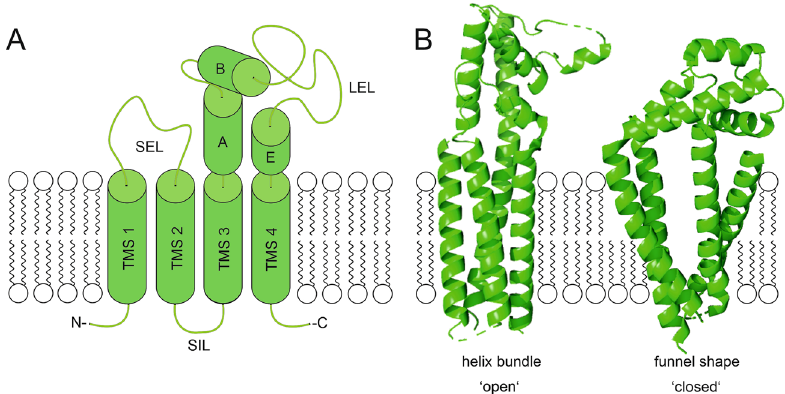
Figure 1. Tetraspanin topology and open-/closed-conformation. Tetraspanin embedded into a membrane bilayer; top and bottom correspond to the extracellular and intracellular side, respectively. ( A ) Schematic depiction of the tetraspanin’s topology including four transmembrane segments (TMS1–4), a small extracellular loop (SEL) and a large extracellular loop (LEL, shown with the conserved helical domains A,B,E), a small intracellular loop (SIL) and a N and C terminus. This illustration was modified from Hochheimer et al. 11 . ( B ) Different conformations proposed for CD81 referred to as helix bundle/’open’ (left, based on PDB: 7JIC) and funnel shape/’closed’ (right, basd on PDB: 5TCX) that differ in the arrangement of the TMSs and the orientation of the LEL; the right structure represents the closed conformation as defined by Zimmerman et al. 12 . The scheme was created using CorelDRAW 2019 (www. corel. com) and the cryo-EM and crystal structure images were created using PyMOL 2.5 (https:// pymol.